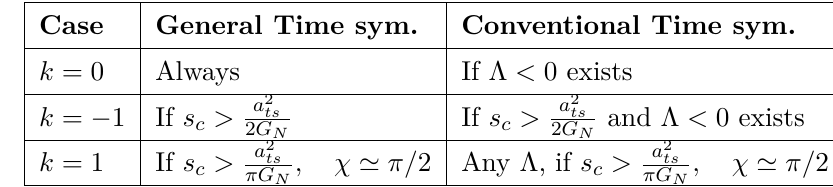
Table 1 . Summary of viable island candidates on time-symmetric slices. The second column corresponds to island candidates in the vicinity of time-symmetric slices without limiting ourselves to perfect fluids with positive definite energy densities, while the third column corresponds to the inclusion of this limitation. The flat and open universe cases here include all possible spatial time- symmetric islands χ (cid:29) 1 , while the closed universe is limited to the χ ' π/ 2